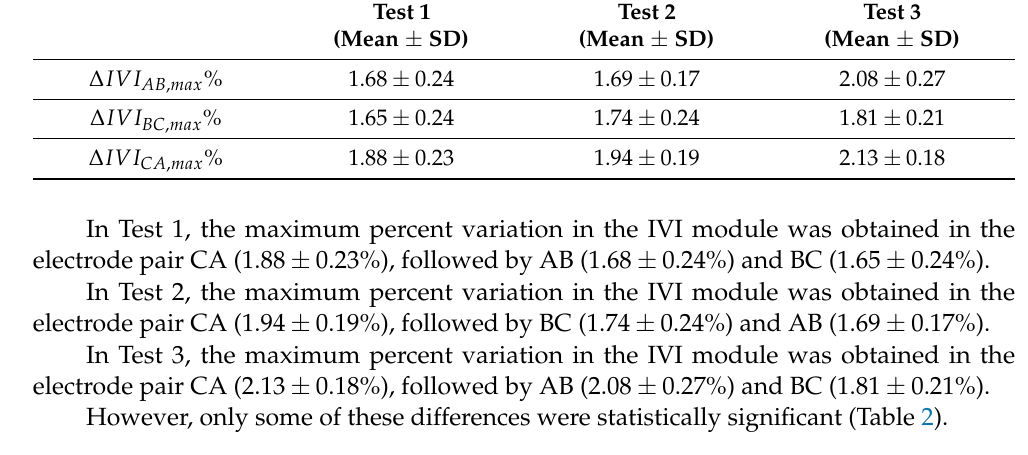
Table 2. p -value obtained from Student’s t -test comparing ∆ IVI max % under different working conditions (Test 1, Test 2 and Test 3) for the three pairs of electrodes (AB, BC and CA). The asterisk indicates significant p